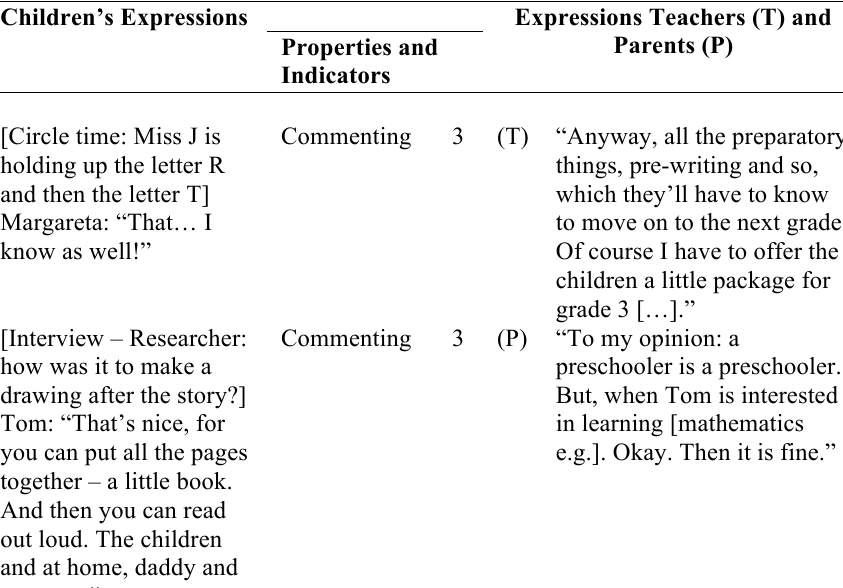
Table 5 Children’s Expressions Corresponding With a Teacher’s and a Parent’s Expression on Level B Children’s Expressions Expressions Teachers (T) and